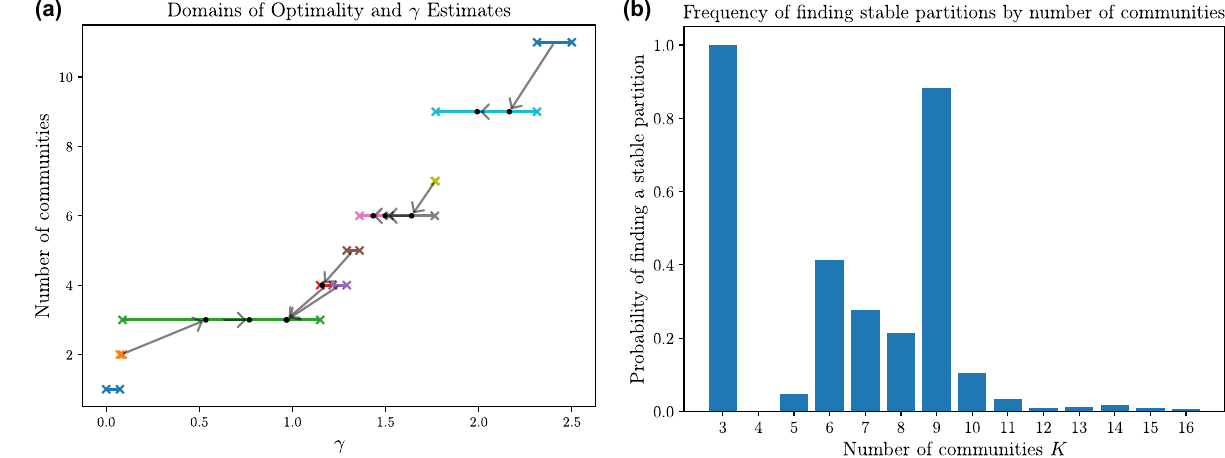
Figure 3. Hierarchical block model networks with 3 communities of 3 subcommunities each. ( a ) The parameter map on a single network realization, plotted in the manner of Figure 2d with each line segment between ‘x’ symbols indicating the domain of optimality of a partition and the “correct” estimate of γ indicated by an arrow from its midpoint to corresponding dot. Stable fixed point partitions with 3, 6, and 9 communities are identified by each having its γ estimate within its own domain. ( b ) Frequencies of stable partitions of K communities on 500 realizations from this model. A 3-community structure is always identified and a stable 9-subcommunity structure appears in ∼ 90% of realizations. Other numbers of communities are also frequently identified. Each network realization was partitioned with 1000 runs of Louvain on a uniform grid of γ ∈ [ 0, 2.5 ]